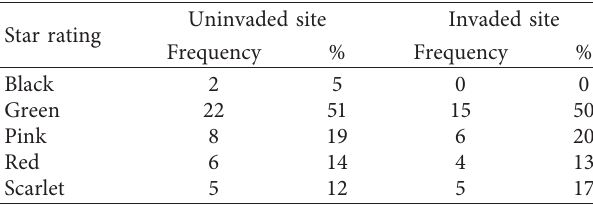
Table 6: Conservation star rating of naturally regenerated tree species on study sites.